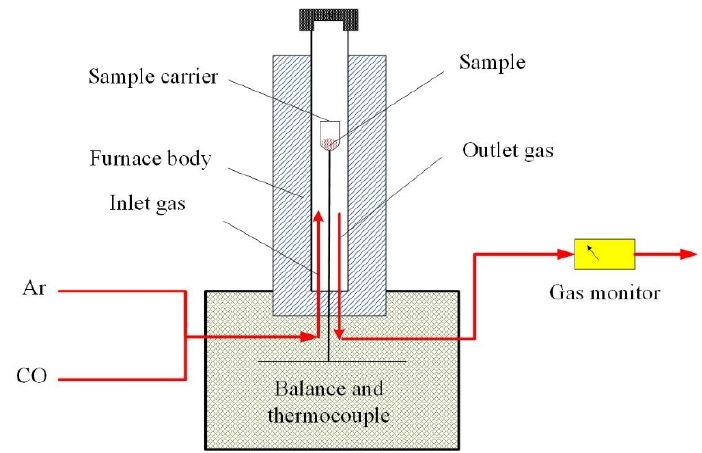
Figure 1. Experimental apparatus.